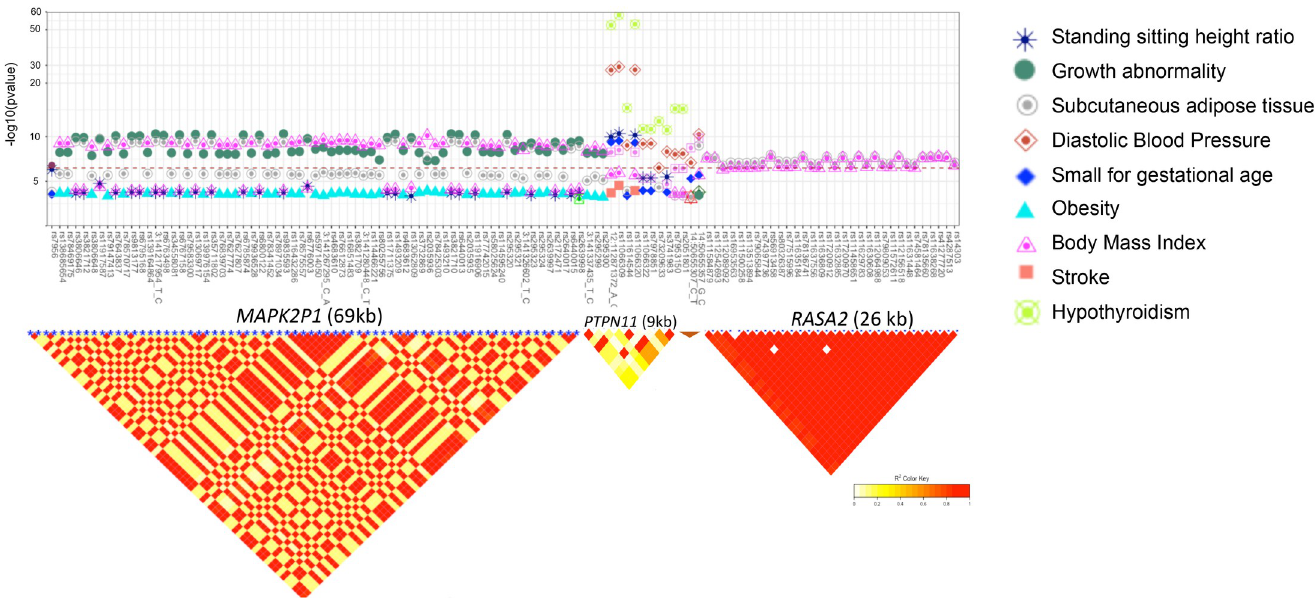
Fig 4. PheWAS result and linkage plot for variants with pleiotropy in RAS-opathy genes. Associations between variants with pleiotropic effects in MAP2K1 , PTPN11 , SOS2 and RASA2 , and HPO terms (a) and linkage between the variants (b). The red line represents the level of significance after Bonferroni correction (p = 2.7x10 -07 ).